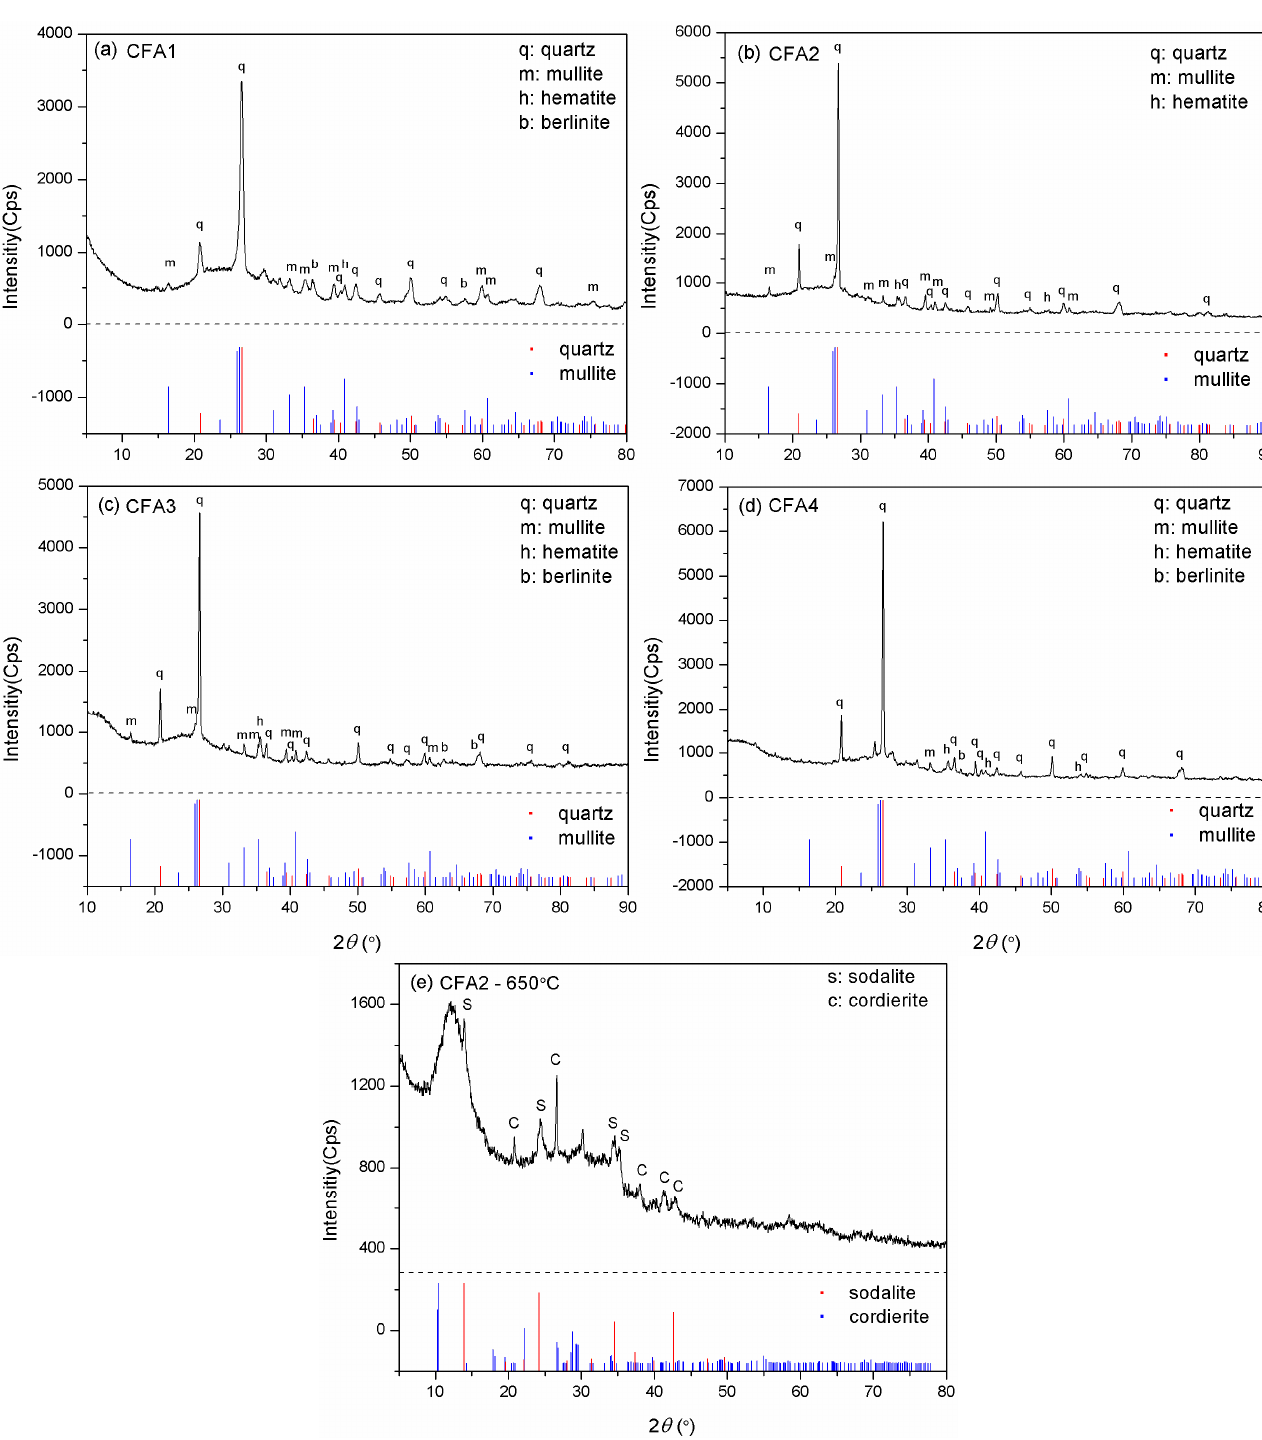
Figure 1. XRD patterns for ( a ) CFA1, ( b ) CFA2, ( c ) CFA3, ( d ) CFA4, and ( e ) CFA2 residue after fusion at 650